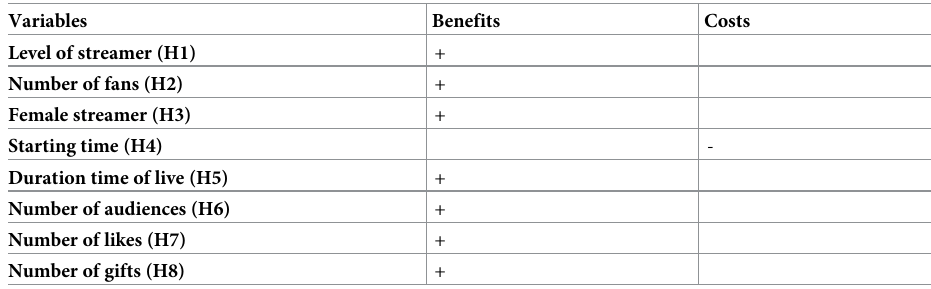
Table 1. Summary of the